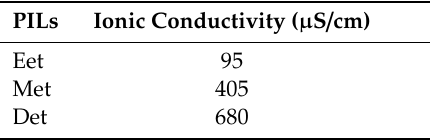
Table 3. Ionic conductivity of Eet, Met, and Det at room temperature. PILs Ionic Conductivity ( µ S / cm) Eet 95 Met 405 Det 680